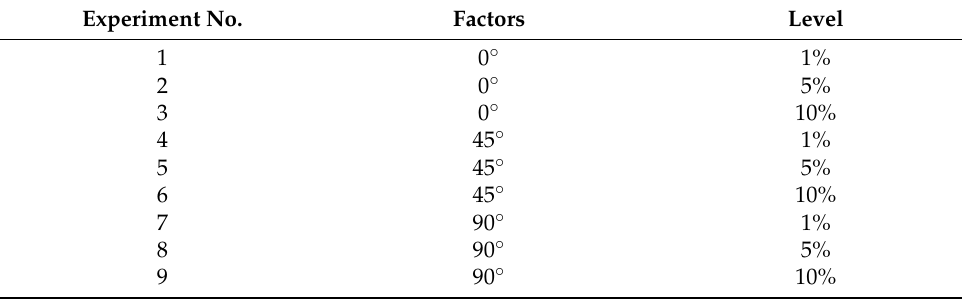
Table 3. Combination of parameters.